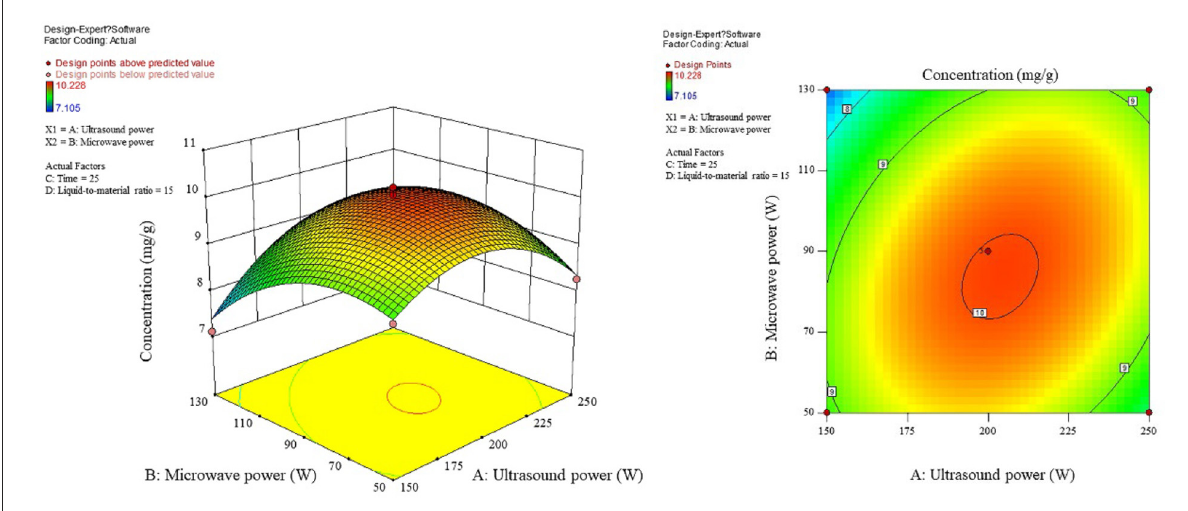
FIGURE3 Effect of the interaction of ultrasonic and microwave power on content.